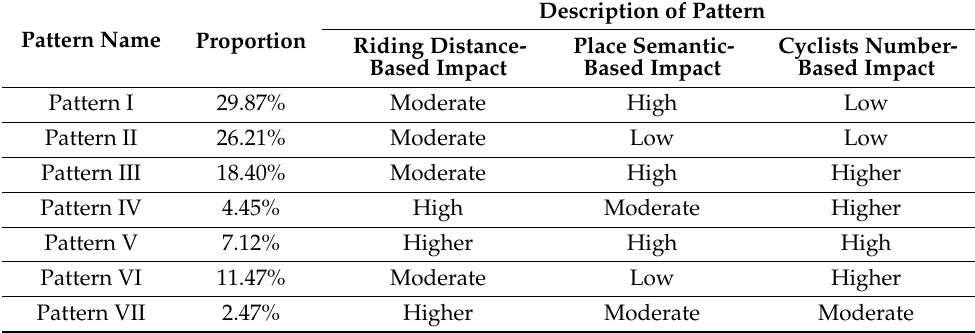
Figure 11. Spatial patterns of impact by multiple factors. Table 2. Statistical and descriptions for the spatial patterns on workday.